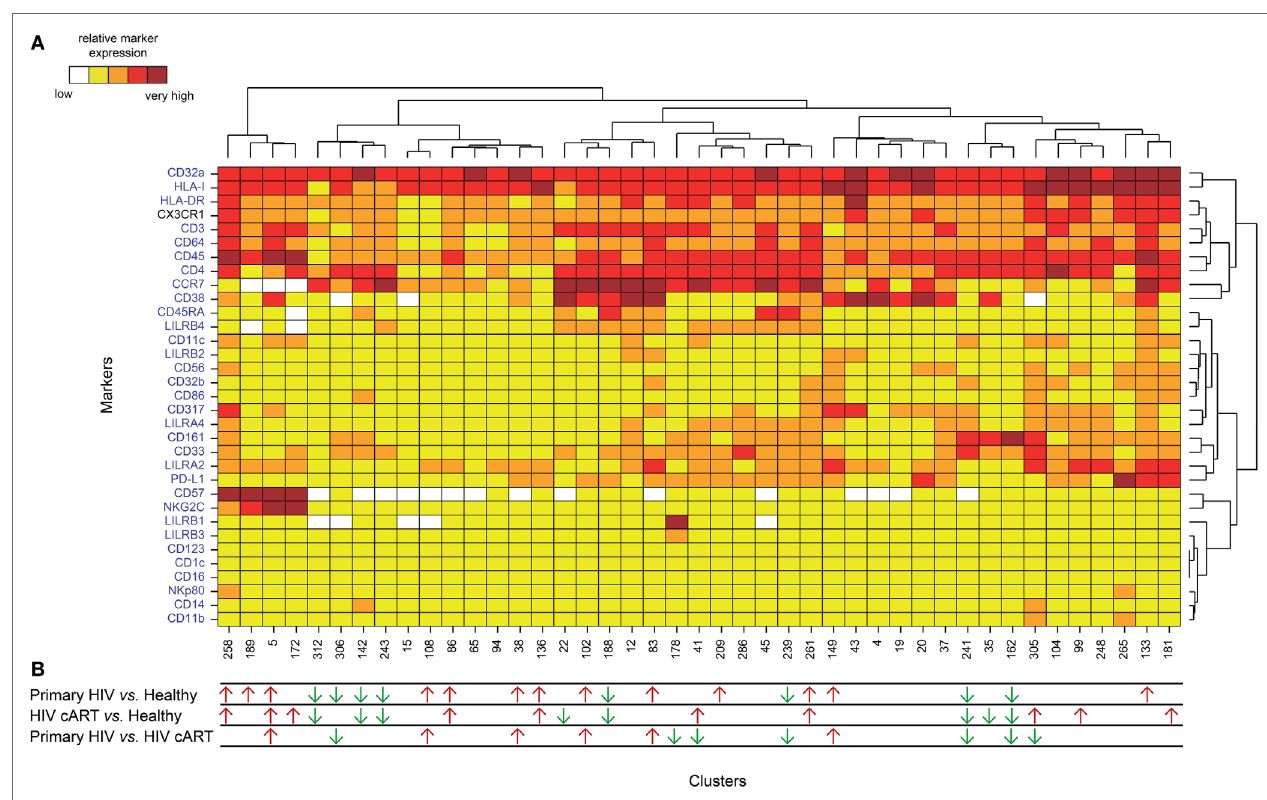
FigUre 2 | Phenotypic landscape and variation in cell abundance of CD32a + CD4 + T-cell clusters from HIV-infected and healthy donor samples. (a) Heatmap showing relative marker expression for CD32a + CD4 + T-cell clusters. The mean of the median expression of each marker was determined and classified using a five-tiered color scale, from white (not expressed) to dark red (highly expressed), according to their range of expression (5th to 95th percentile) throughout the dataset. Clustering markers are shown in blue. Hierarchical clustering of both the cell clusters and clustering markers were performed and represented using dendrograms. (B) Chart summarizing the clusters showing significantly different cell abundances between the biological conditions [differentially abundant clusters (DACs)]. For each comparison of corresponding DACs, red arrows indicate an increase in the abundance of the cell cluster, whereas green arrows indicate a decrease in abundance, for the left condition relative to that on the